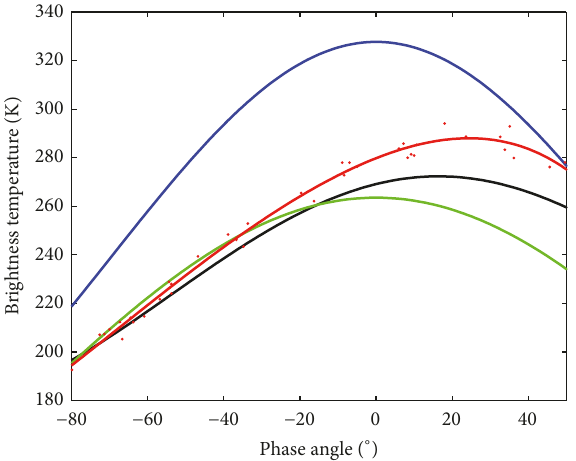
Figure 4: Disk-integrated brightness temperatures of the Moon for different phase angles relative to full Moon at 89 GHz. Blue: (4) in [1], green: (4) and Table II in [4], black: Keihm ([13], numbers from web page and personal communication), and red: MHS on NOAA- 18, single measurements (dots) fitted with polynomial of order five.